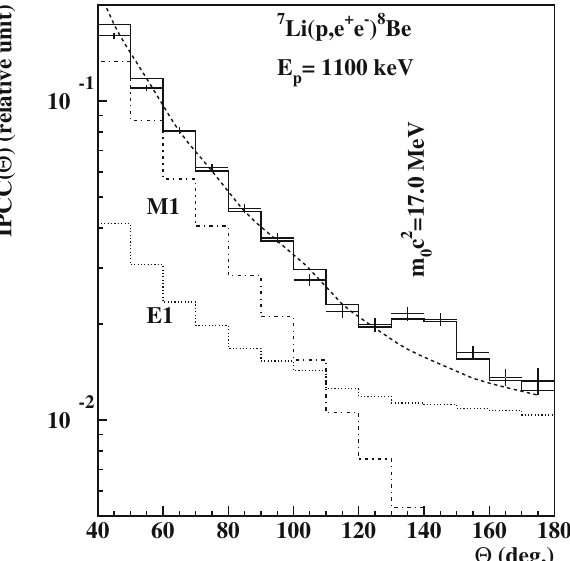
Fig. 3 Comparison of the experimental results obtained for the 18.15 MeV transition of 8 Be (dots with error bars) and the simulated angular correlations of the e + e − pairs assuming E1 (dotted line) and M1 (dashed dotted line) multipolarities. The best fit (black histogram) is a sum of the simulated backgrounds (dashed line) and the simulated contribution of the hypothetical X17